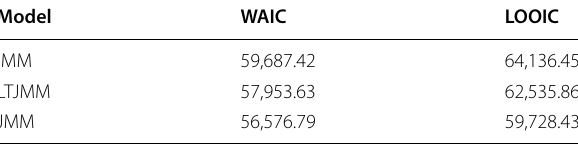
Table 2 Model selection